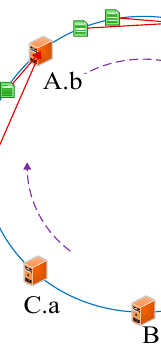
Figure 12. The servers are deployed in the adjacent locations in the hash circle.